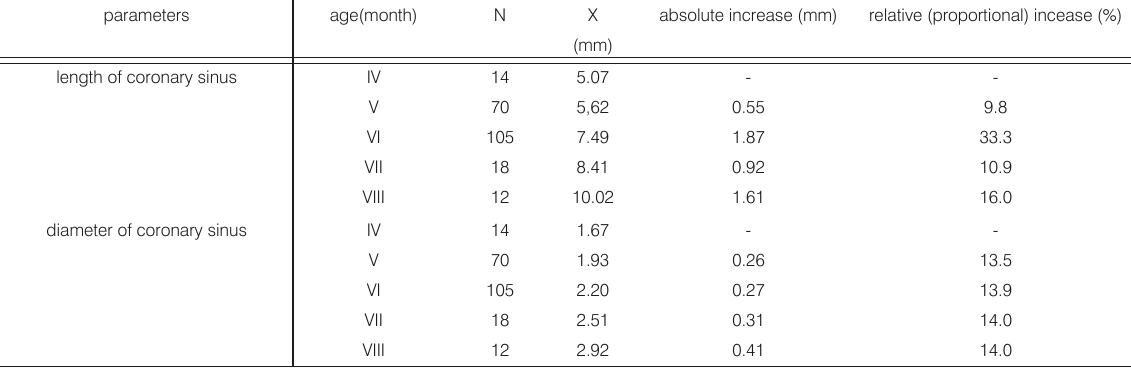
Table 5. The increases (absolute and proportional-relative) of the investigated linear features in fetal subjects of both sexes and the growth index determined based on the differences between consecutive age groups. X – average, N – number.